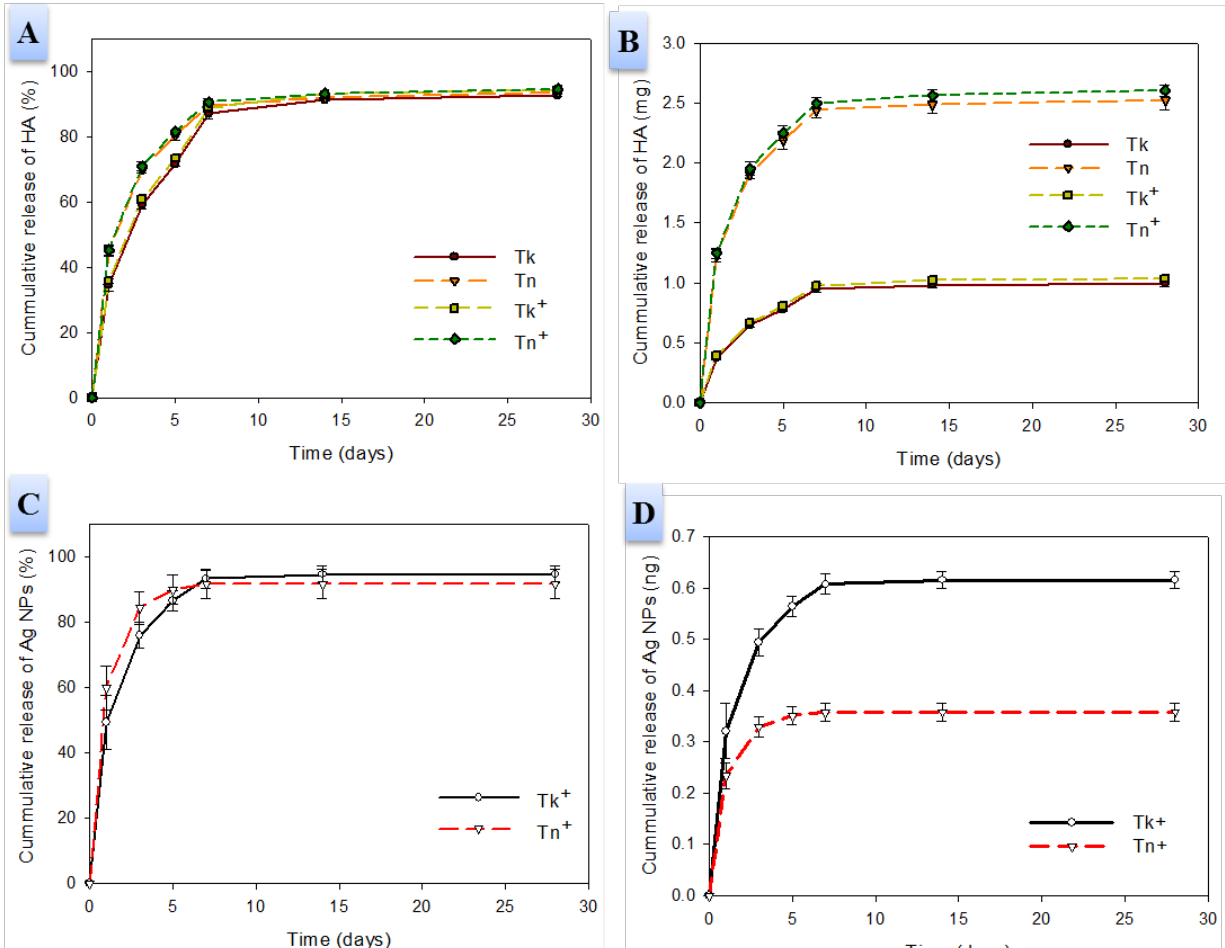
Figure 5. The cumulative release percentage ( A ) and cumulative released mass ( B ) of HA. The cumulative release percentage ( C ) and cumulative released mass ( D ) of Ag NPs.